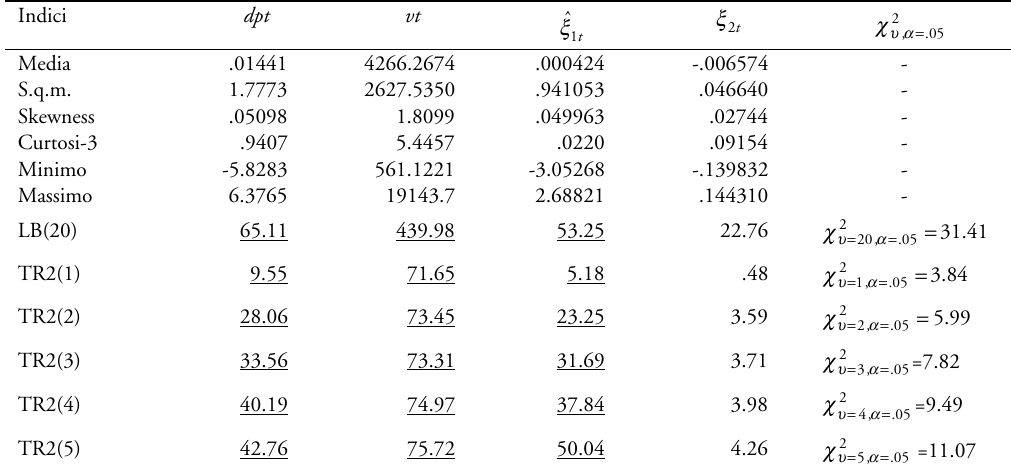
Valori dei principali indici statistici per le serie dp Le statistiche del tipo LB e TR2 significative sono